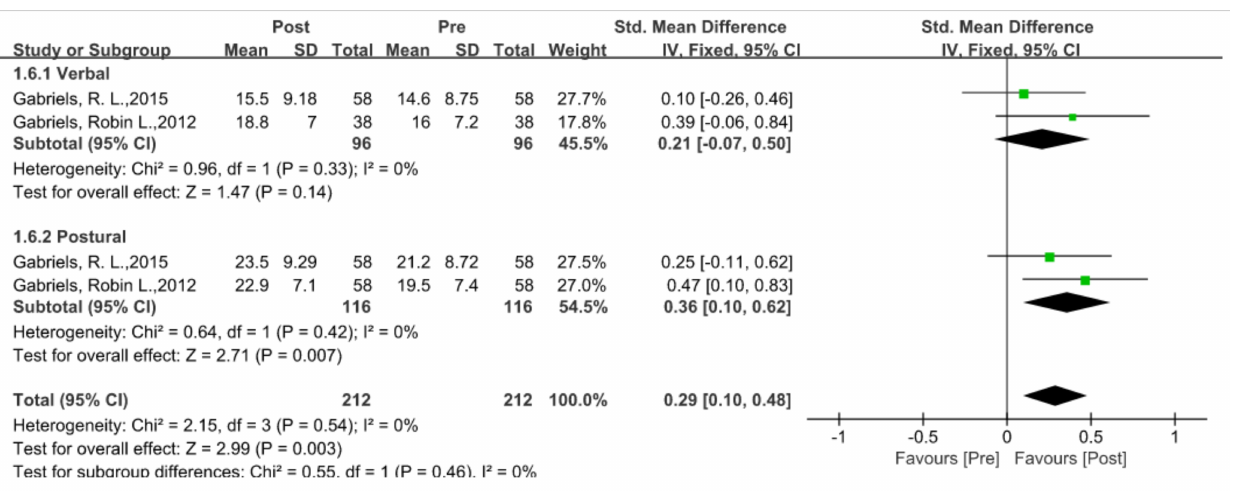
Figure 8. Forest plot of sensory function (pre-post comparison) using SIPT